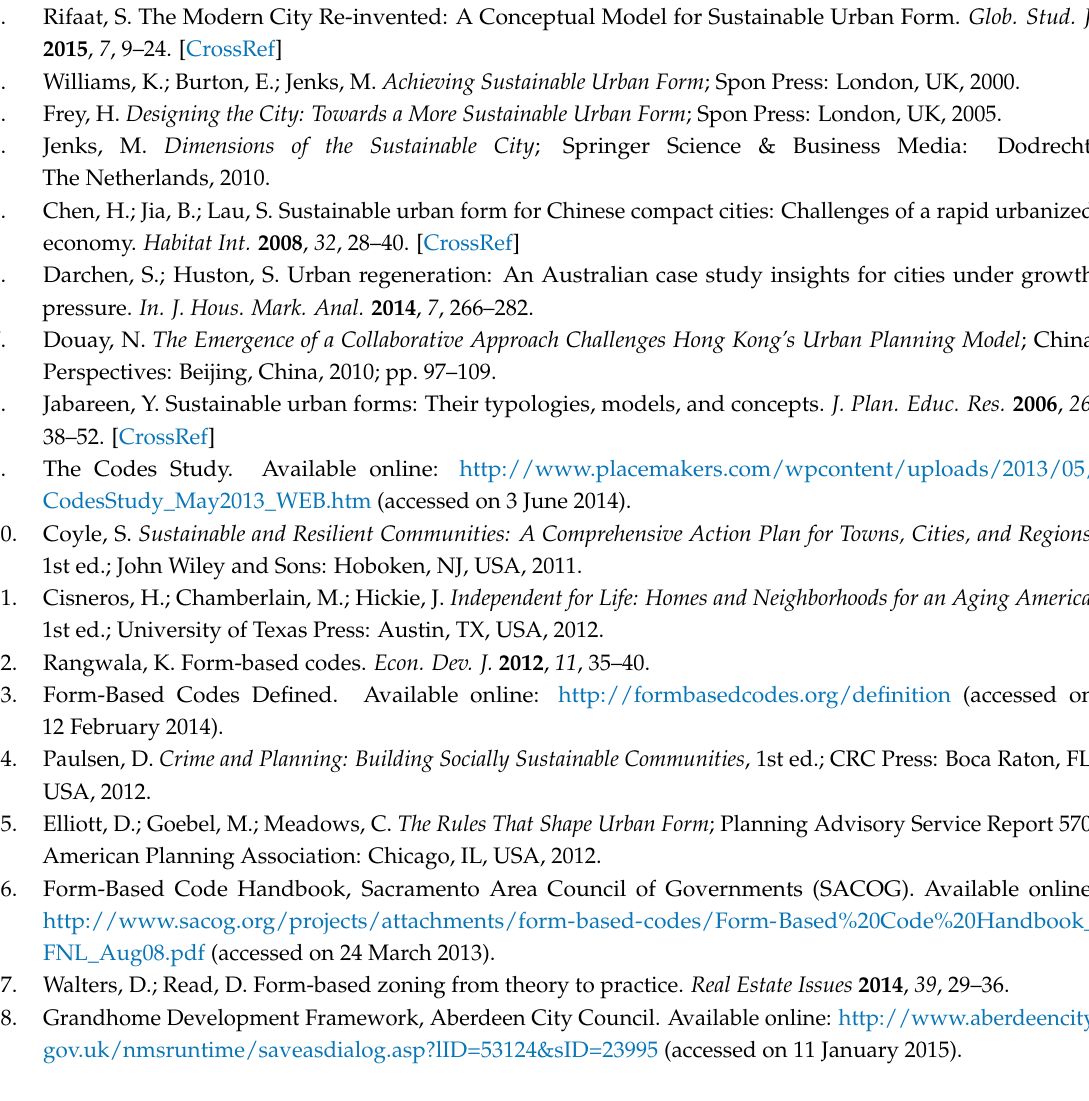
Table S1: Summary of the results of the comparison between the components of the FBCs with the local urban form-related regulations and guidelines for new urban neighborhoods in Abu